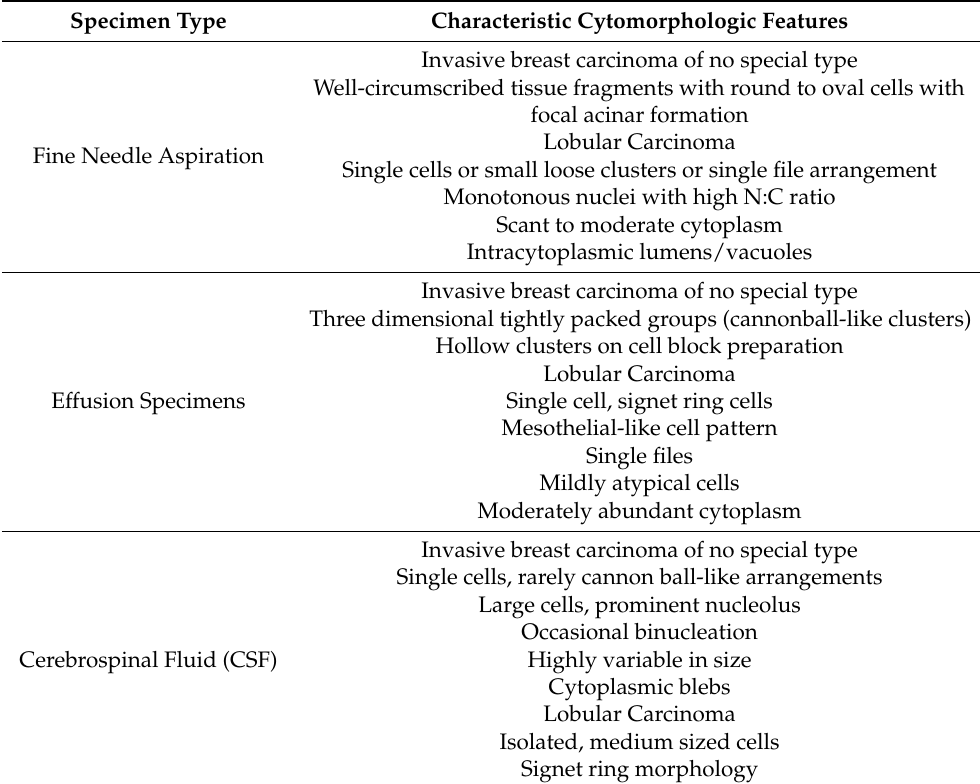
Table 1. Cytomorphology of MBC in various cytology specimen types (summarized from the references [12,23,32 −4 3]) .